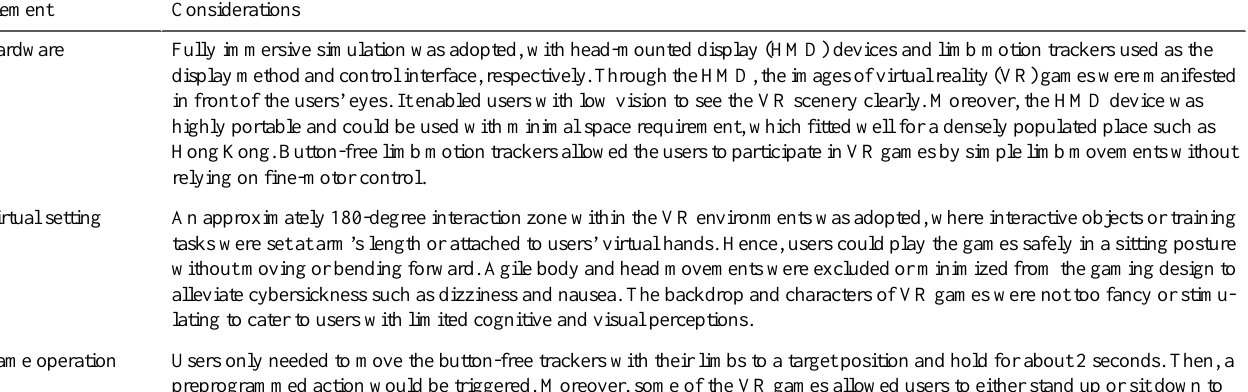
Table 1. Some of the key considerations during program development to cater to the different conditions and disabilities of the users. ConsiderationsElement